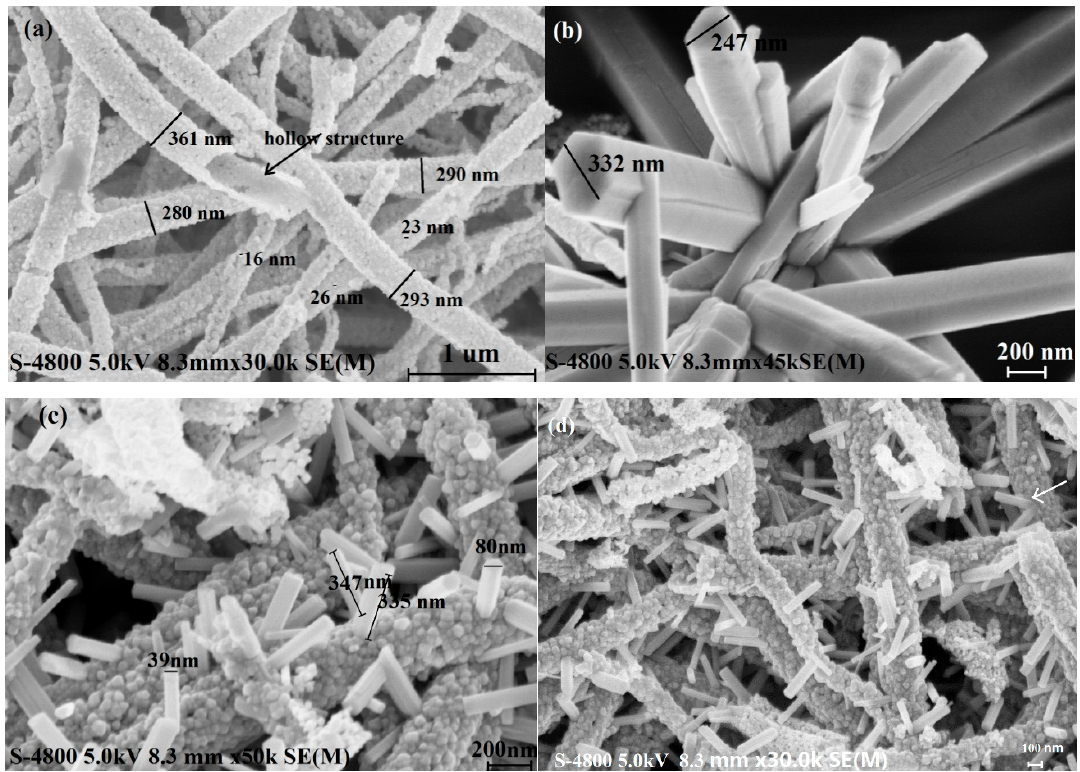
Figure 2. SEM images of ( a ) SnO 2 nanofibers, ( b ) ZnO nanorods, ( c , d ) SnO 2 /ZnO nanofibers.